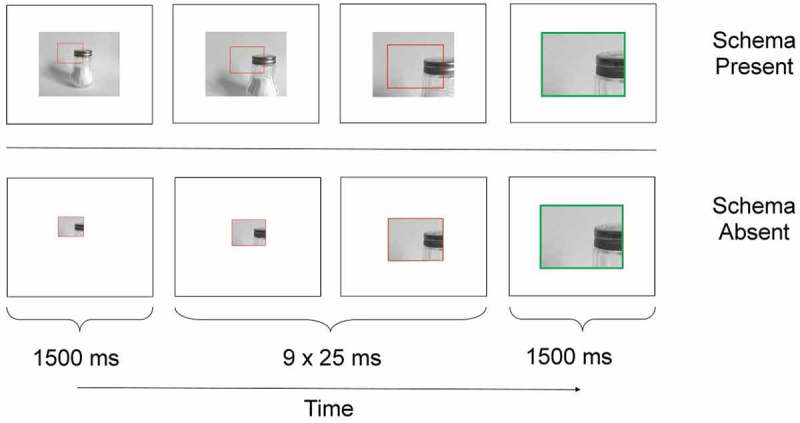
Schematic illustrations of example presentation trial screens for schema-present (top) and schema-absent (bottom) stimuli in Experiment 3. For each row, leftmost image indicates start screen, middle images depict two of nine zooming screens and rightmost image indicates end screen.